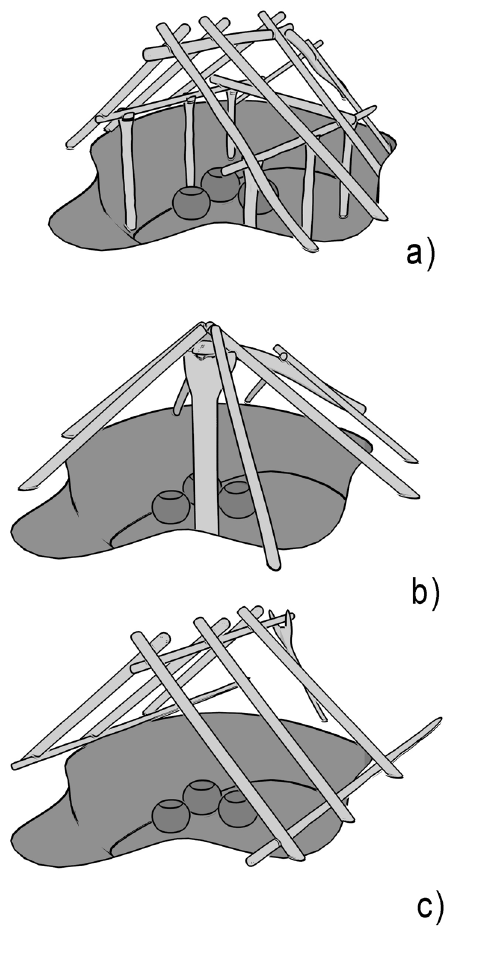
Figure 8: Plans of the features with post-holes inside.